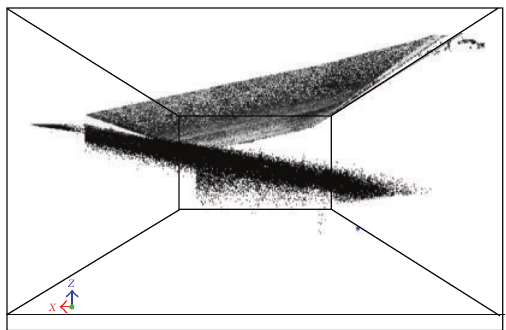
Figure 7: Vertical section, showing in the lower part of the points cloud the wrong points generated by a specular e ff ect due to the achievement of Brewster angle by the incident laser ray in respect to the water